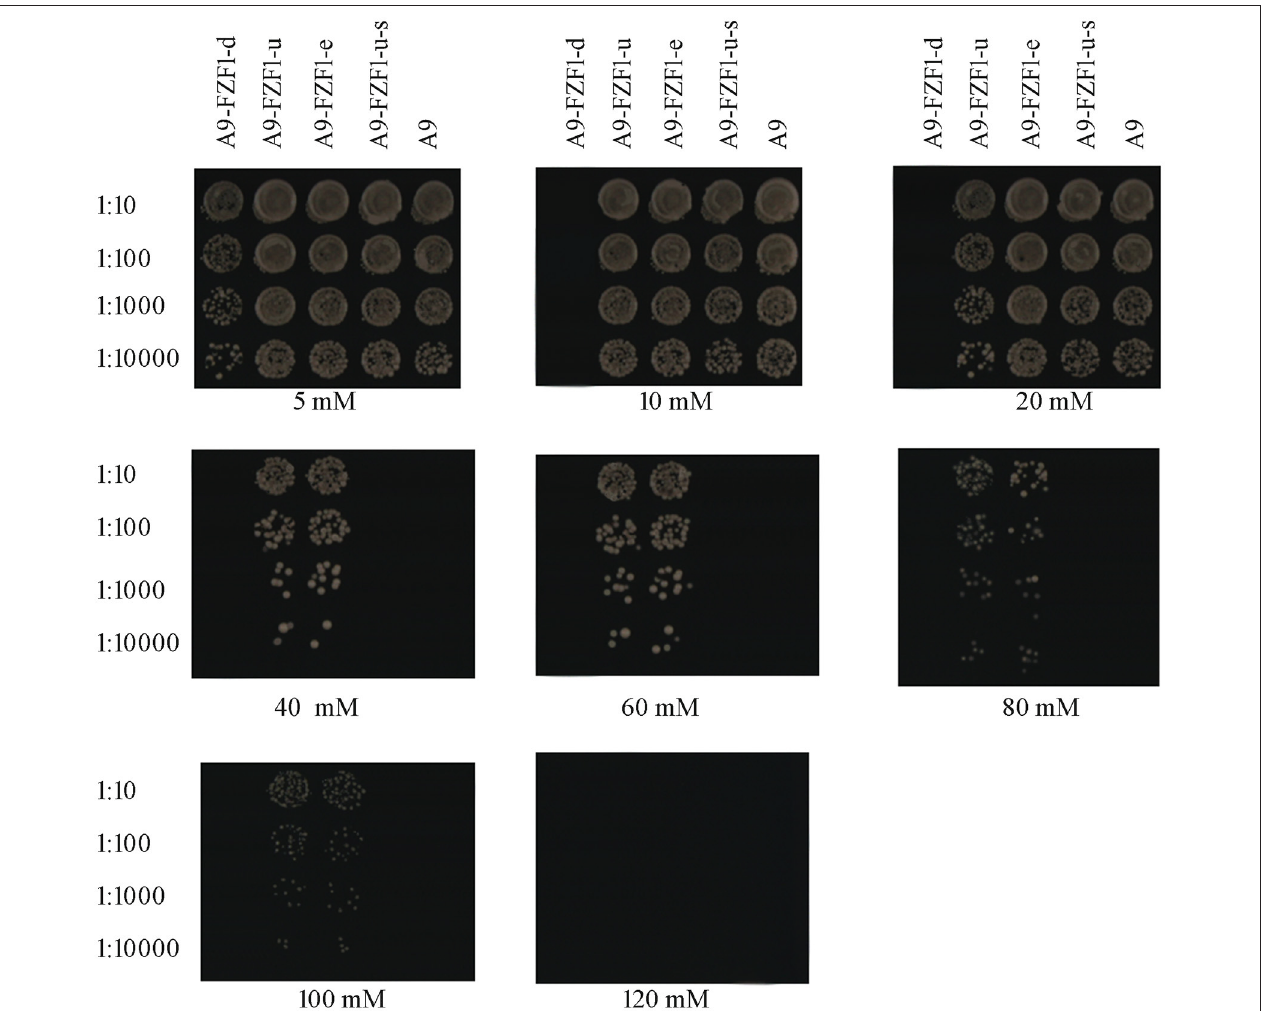
FIGURE 1 | Drop off test experiment: yeast colonies were cultured for 24h in liquid YPD without adding sulfite, then 100 uL of them were diluted with liquid YPD into 1:10, 1:100, 1:1000, and 1:10000 time. Three microliter droplets of yeast dilutions were inoculated onto fresh YPD plates containing 5, 10, 20, 40, 60, 80, 100, and 120mM of sodium sulfite, and 80mM of succinic acid (pH 3.5). After growing on the medium for 3 days, the sulfite tolerance levels of the colonies were recorded by visual analysis of